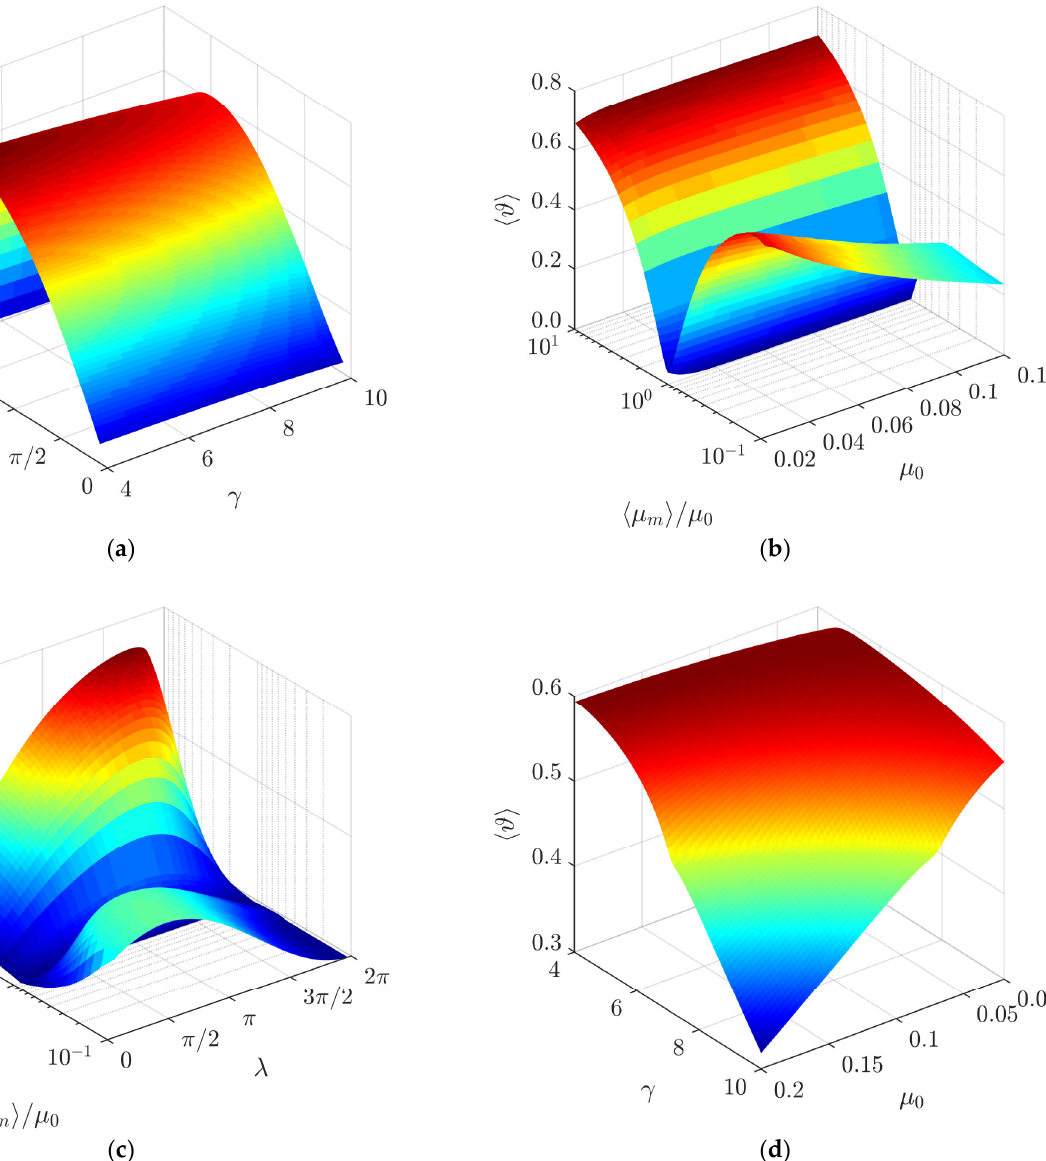
Figure 9. Average nondimensional velocity depending on the following: ( a ) λ and γ when μ 0 = 0.1, ⟨ μ m ⟩ / μ 0 = 0.25, ϕ = 0; ( b ) ⟨ μ m ⟩ / μ 0 and μ 0 when γ = 5, ϕ = 0, λ = π ; ( c ) ⟨ μ m ⟩ / μ 0 and λ when μ 0 = 0.1, γ = 5, ϕ = 0; ( d ) γ and μ 0 when ⟨ μ m ⟩ / μ 0 = 4, ϕ = 0, λ = π .